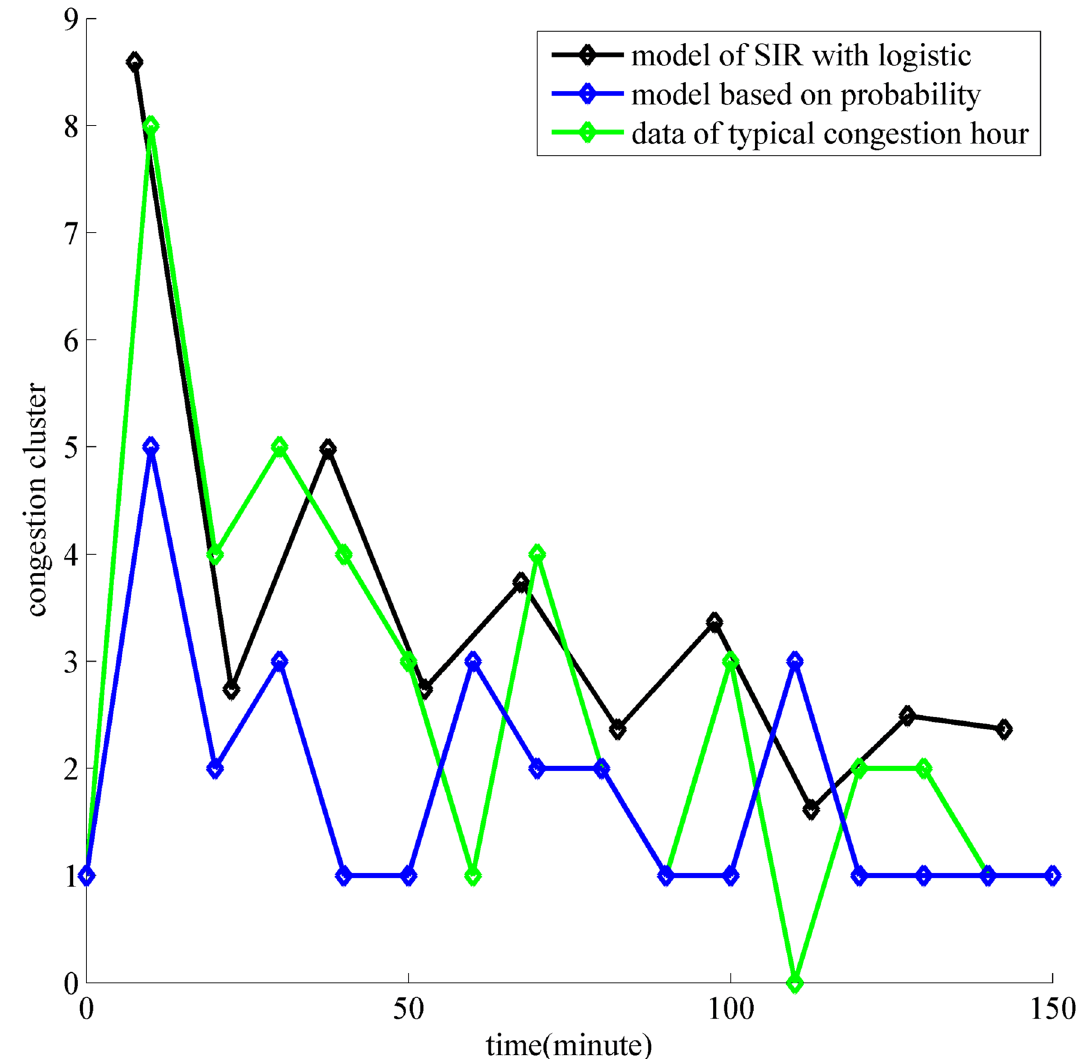
Fig 5. Comparison model with reality and model with model.